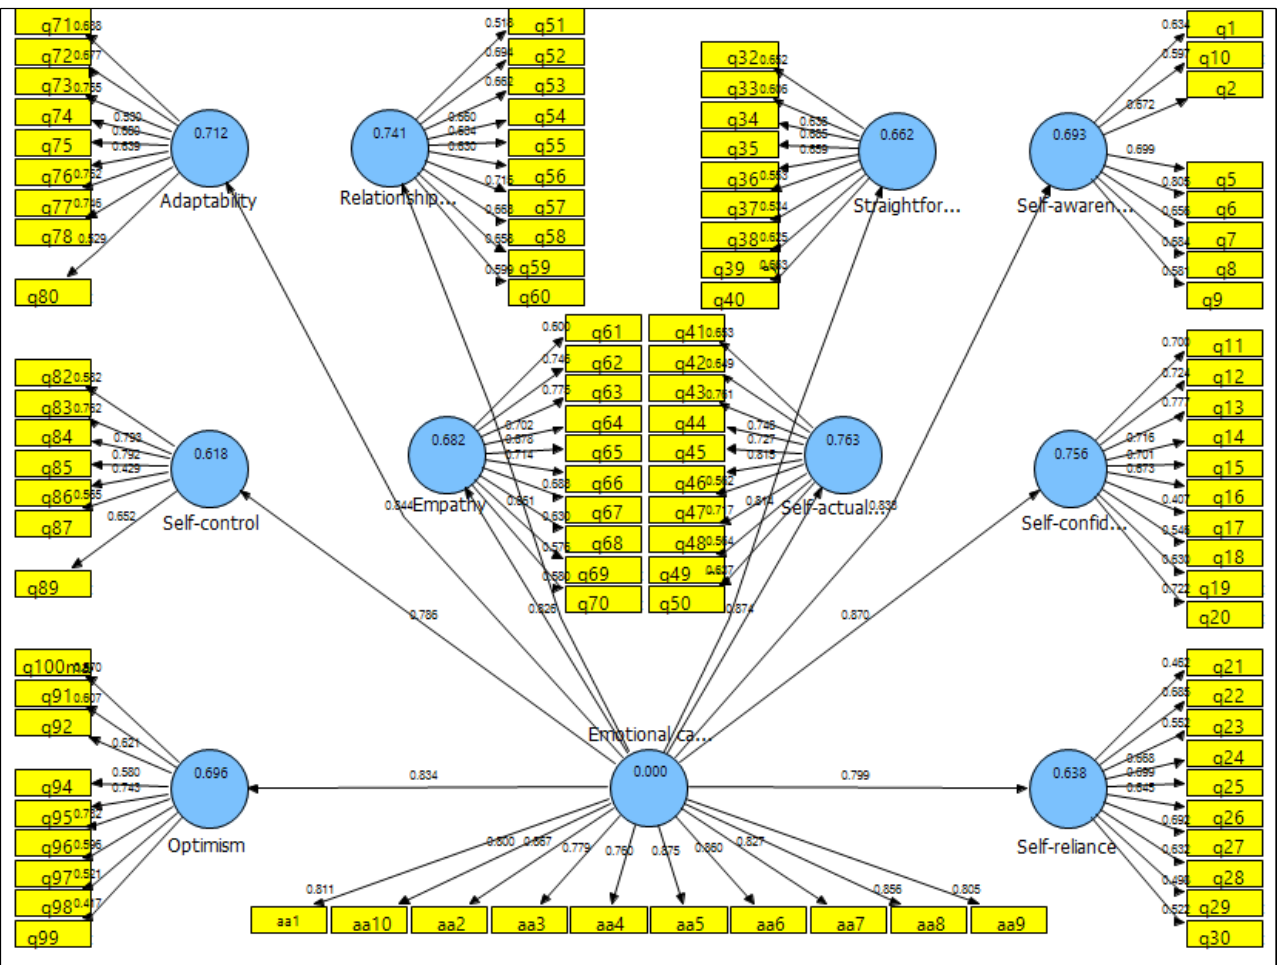
Figure 1. Factor loadings and (cid:1844) (cid:2870) coefficients of the structural model.